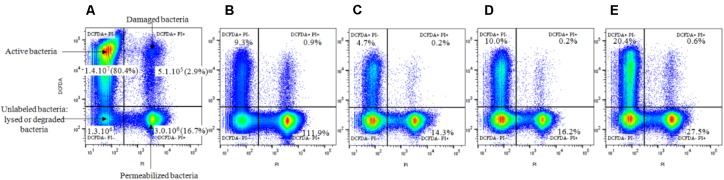
Influence of the gas nature (N2, O2, and Ar) after 15 min of NTP treatments on S. aureus physiological states, determined by FC. The fluorescent dot plots were gated from the bacterial population previously determined and were obtained in response to double-staining with DCFDA and PI. (A) Control: total labeled events (1.93 × 107 events/mL = 100%); (B) 15 min low pressure; (C) 15 min O2; (D) 15 min Ar; (E) 15 min N2. (B–E) Expressed as a percentage of the total labeled events of the control.